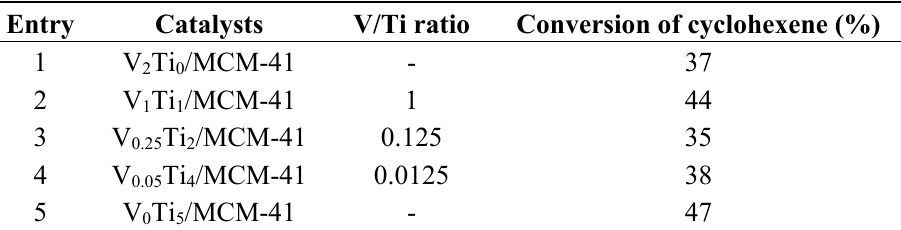
Table 4. Photocatalytic epoxidation at 60 °C for 6 h using various V-Ti weight ratios. Entry Catalysts V/Ti ratio Conversion of cyclohexene (%)